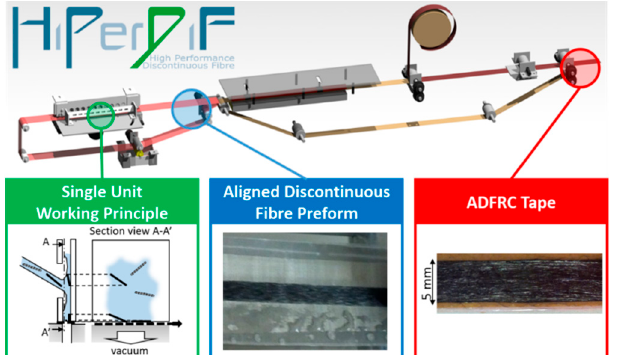
Figure 1. The HiPerDiF technology delivers aligned discontinuous fibres via a fibre-suspended water jet directed at an array of perpendicular plates. The removal of water leads to a highly aligned preform, to be later incorporated with a polymer matrix.